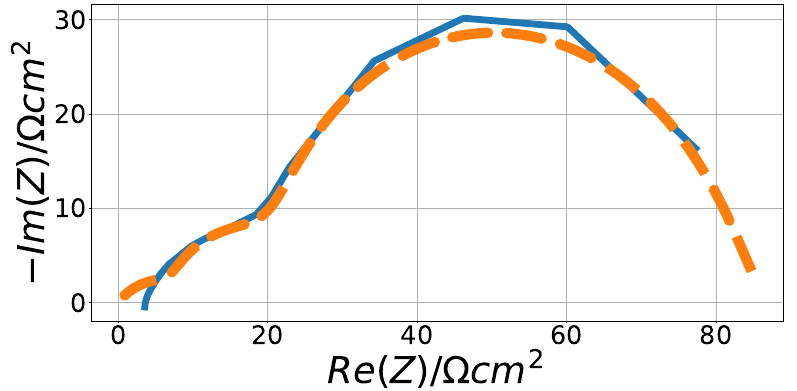
Figure 15. Solid oxide fuel cell fitted impedance characteristic.